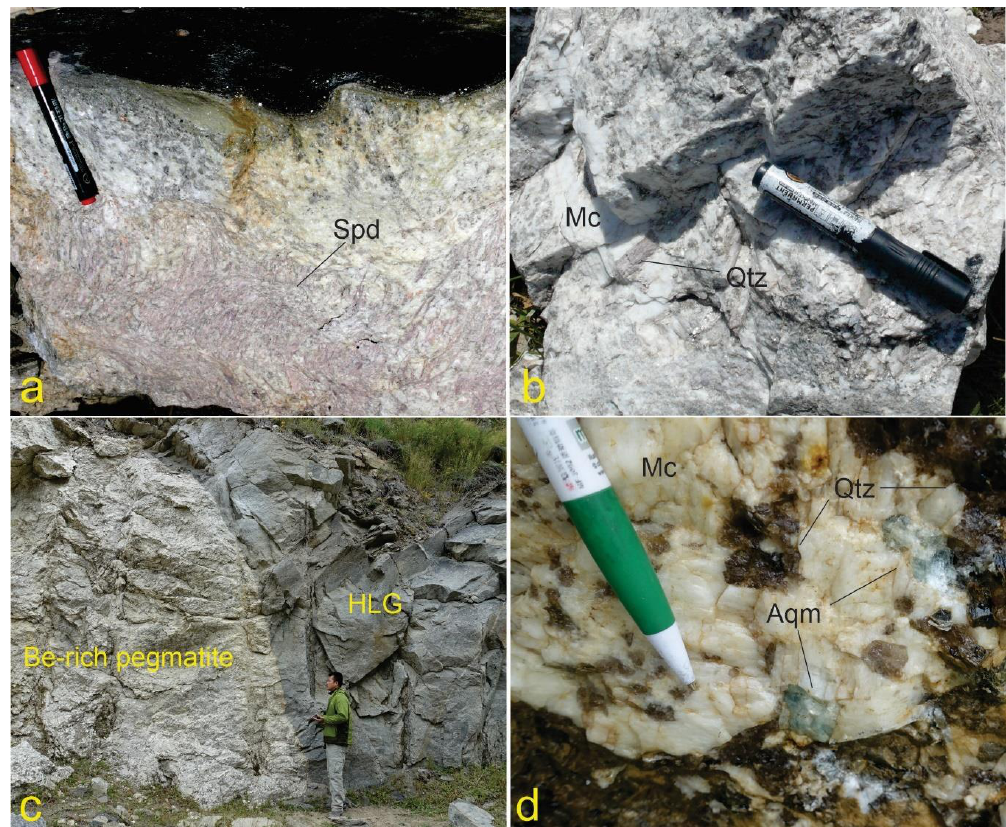
Figure 3. Field photos showing typical textures and mineralogy of the Li-rich pegmatites at Kalu’an-Azubai pegmatite field. ( a ) orientation of pinkish spodumene in the medium- to coarse-grained spodumene-albite-quartz zone and ( b ) the intermediate zone dominated by blocky microcline and quartz. ( c ) A Be-rich pegmatite dike intruded into the Halong granite. ( d ) Coarse-grained aquamarine associated with microcline and quartz in the Be-rich pegmatite. The length of the permanent marker is roughly 15 cm. Abbreviations: Aqm = Aquamarine, Mc = microcline, Qtz = quartz, Spd = spodumene, and HLG = Halong